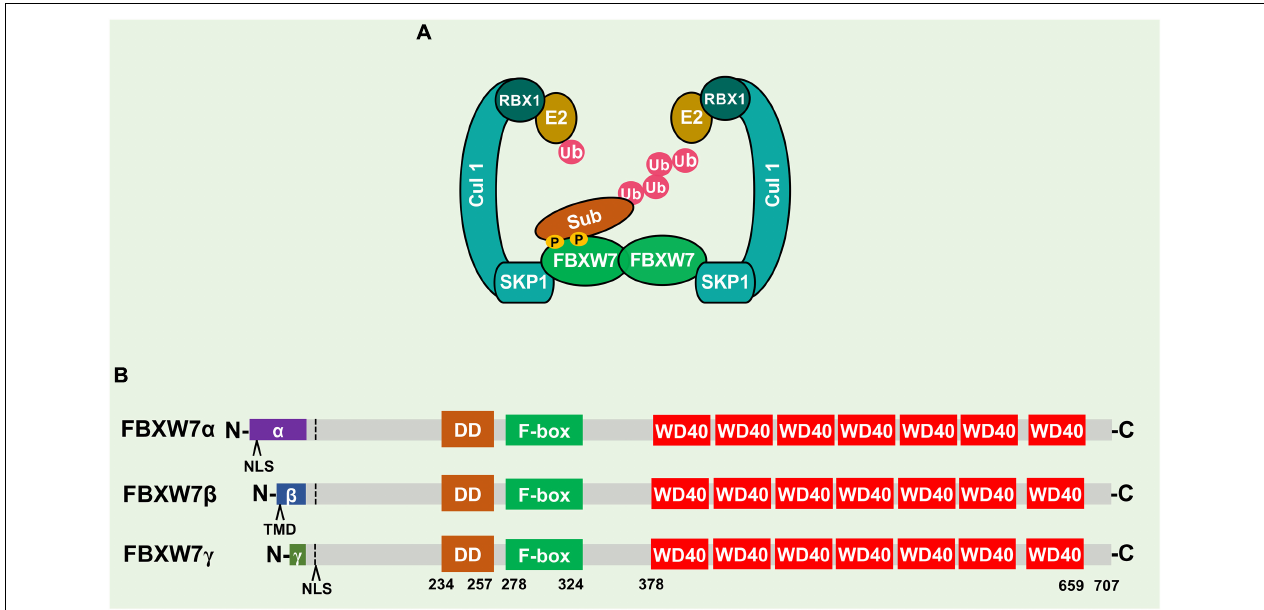
FIGURE 1 | Schematics of SCF, FBXW7, and FBXW7 isoforms. (A) SCF FBXW7 consists of a scaffold cullin-1 (CUL-1), an adaptor SKP1, a RING-domain protein (RBX1/RBX2), and a substrate-receptor F-box protein (FBXW7). Shown is SCF FBXW7 complex in FBXW7 dimerization format for ubiquitylation of a substrate. (B) Three FBXW7 isoforms ( α , β , and γ ) with domain alignment. NLS, nuclear localization signal; TMD, transmembrane domain; DD, dimerization